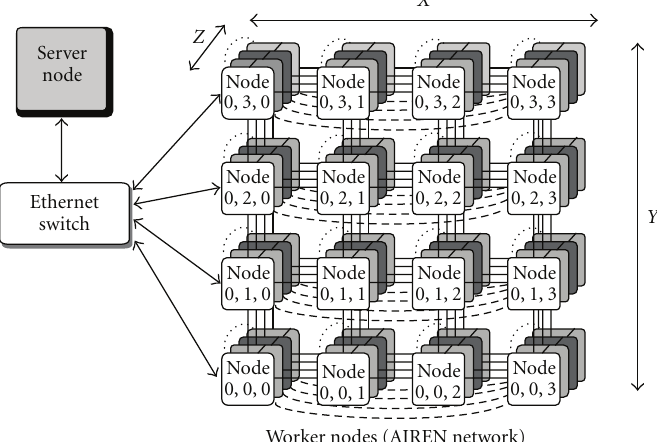
Figure 1: The RCC’s Spirit cluster consists of 64 FPGAs connected in a 4-ary 3-cube through a high-speed network (AIREN).